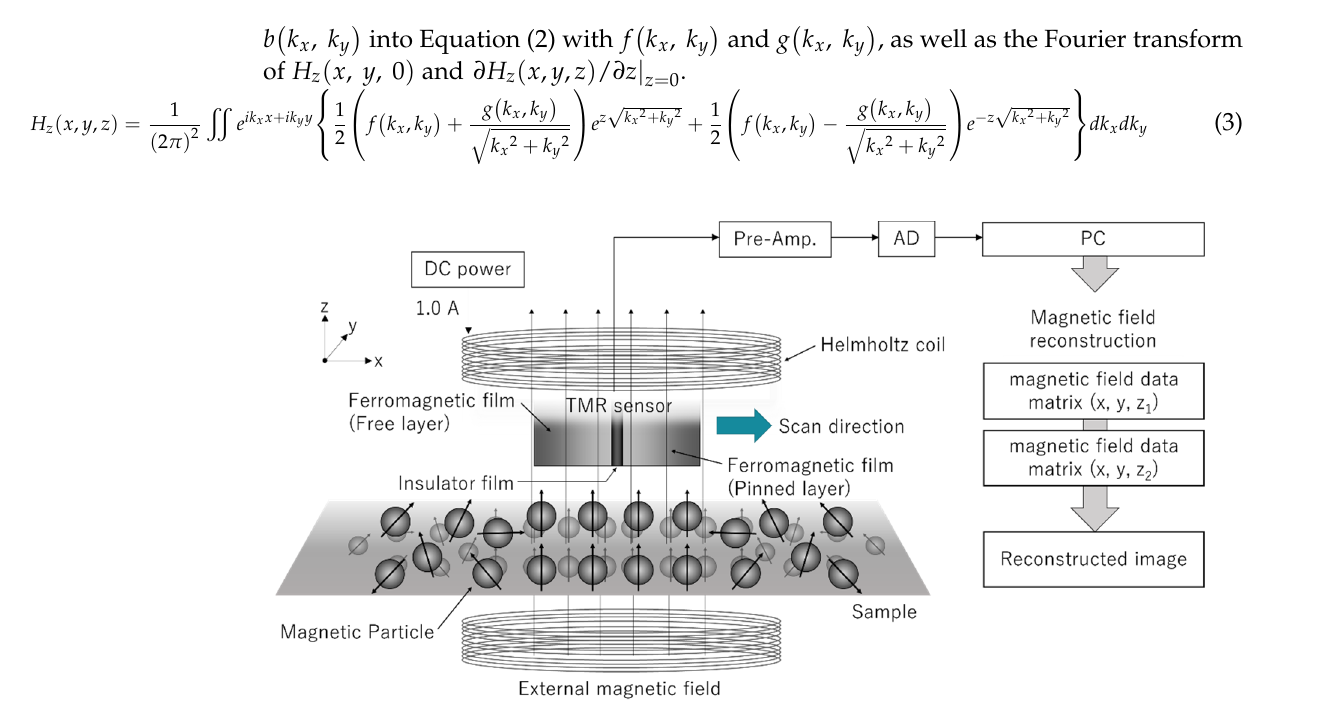
Figure 8. A ferrite magnet sample used in the measurements: schematic of the sample ( a ) and its structure ( b ).